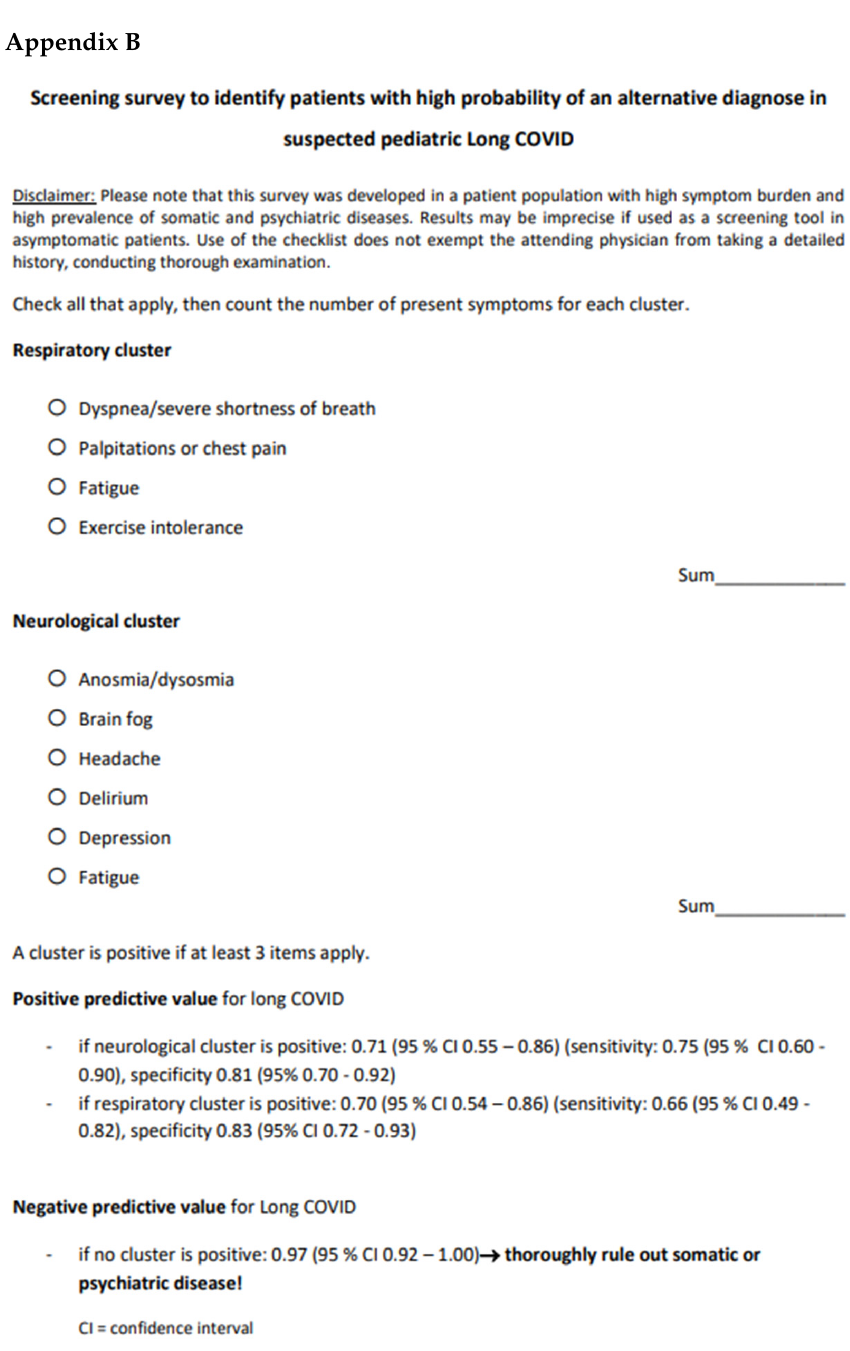
Figure A1. Checklist for the survey of symptom clusters in suspected Long COVID in children and adolescents.